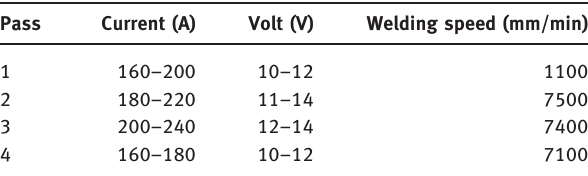
Table 2: Welding parameters in each welding